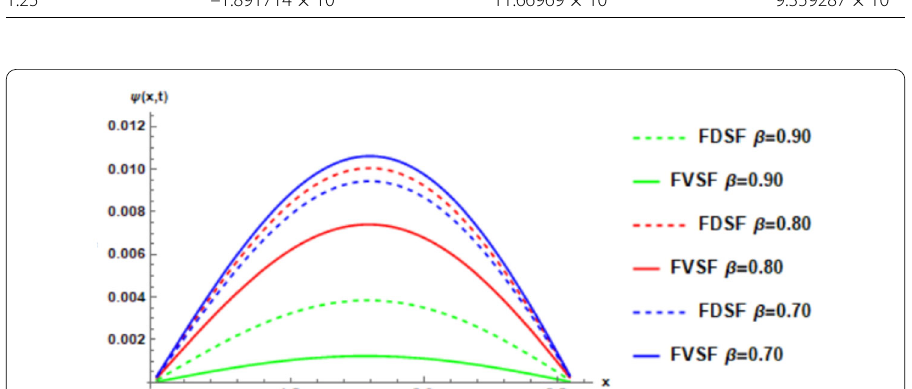
that FVSF provides an excellent agreement with the exact solution rather than the